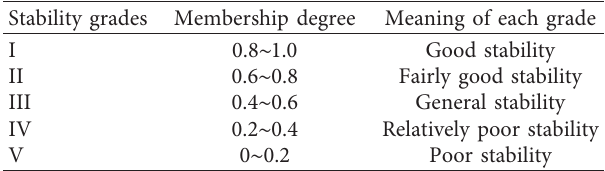
Table 5: Evaluation